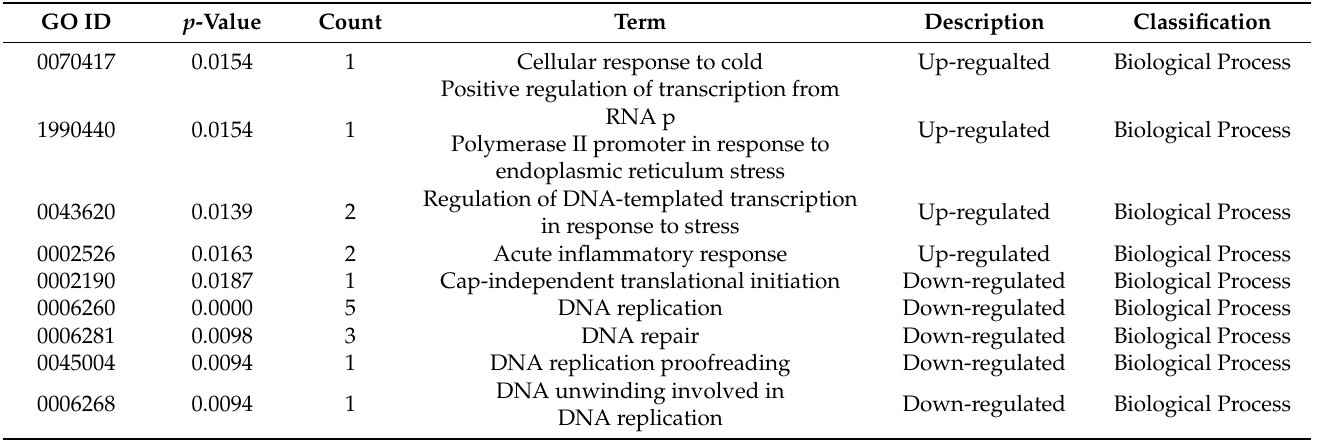
Table 2. GO (gene ontology) enrichment results after the gradual temperature rise (GTR).